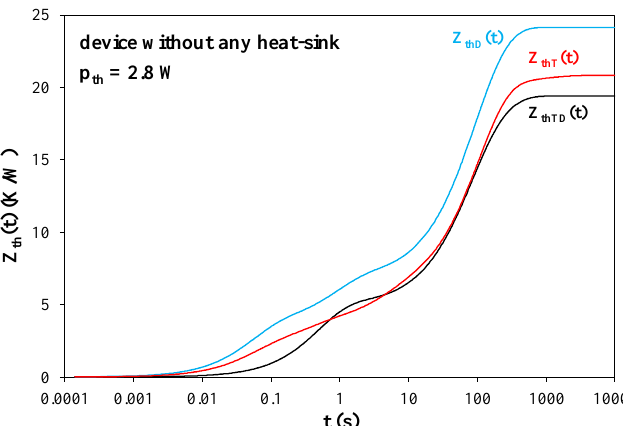
Figure 10. Measured waveforms of self and transfer transient thermal impedances in the tested device operating without any heat-sink.